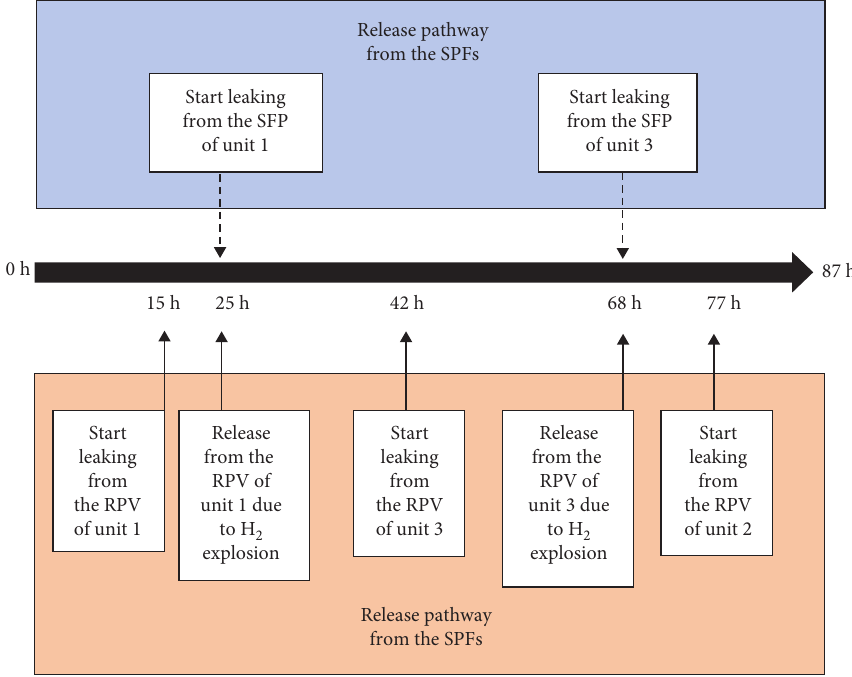
Figure 6: Timeline and release pathways of case 2.